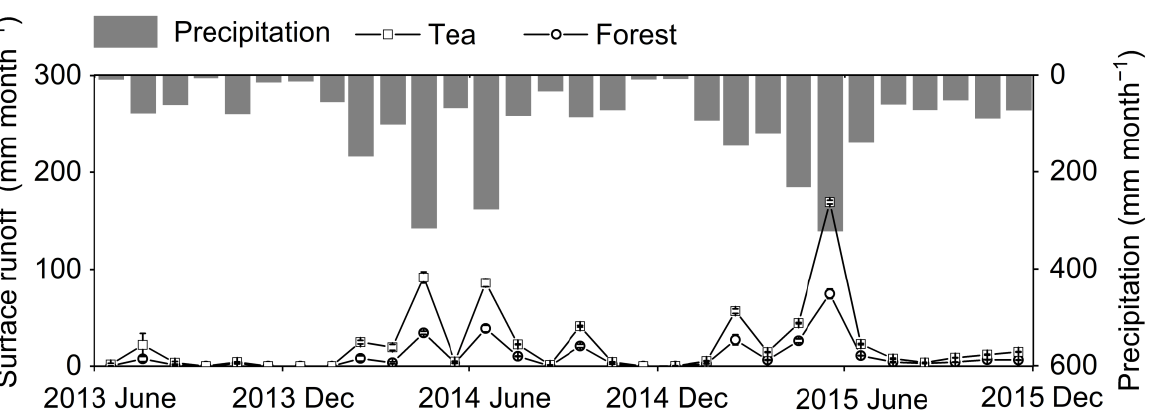
Figure 2. Monthly precipitation and surface runoff depth in the tea and forest systems during the observation period. Table 3. Proportions of the dissolved and particulate in the total nitrogen and phosphorus concentra- tions in the surface runoff in the tea and forest